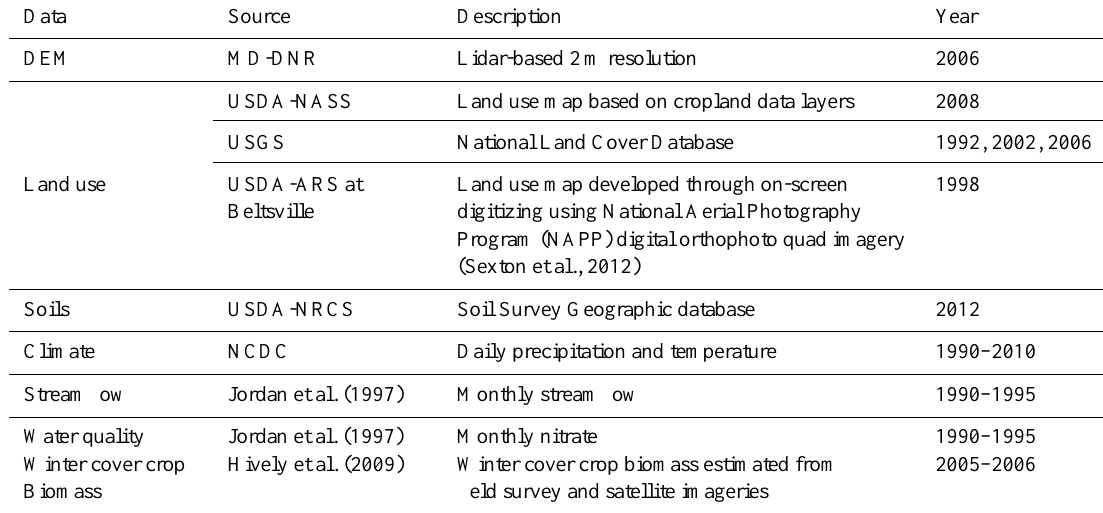
Table 1. List of data used in this